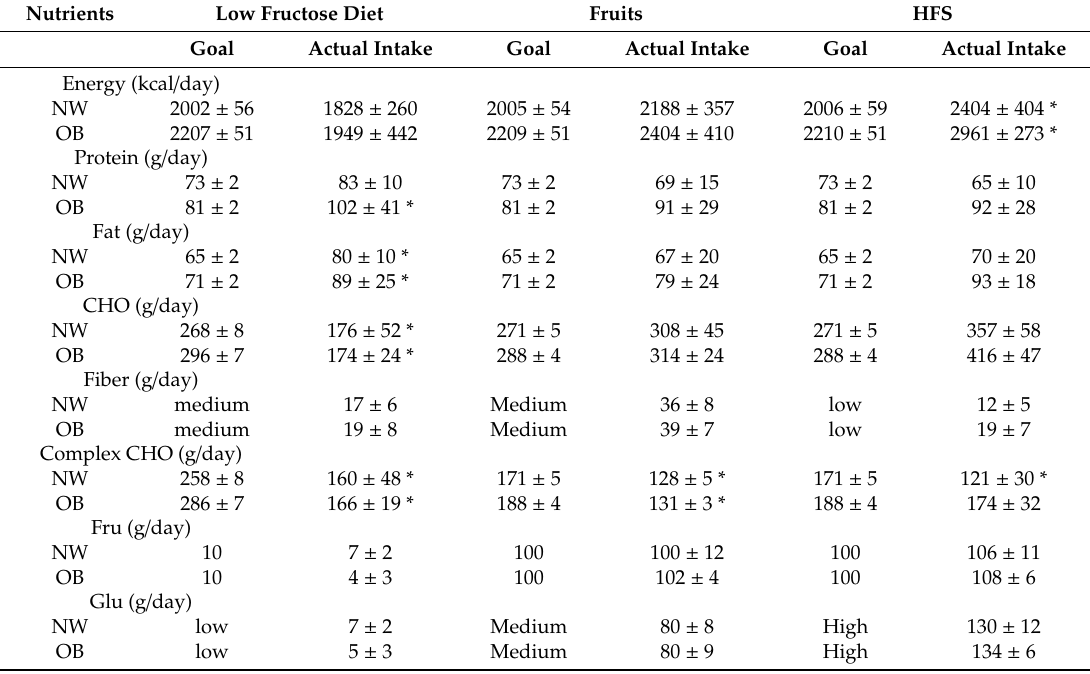
Table 2. Composition of study